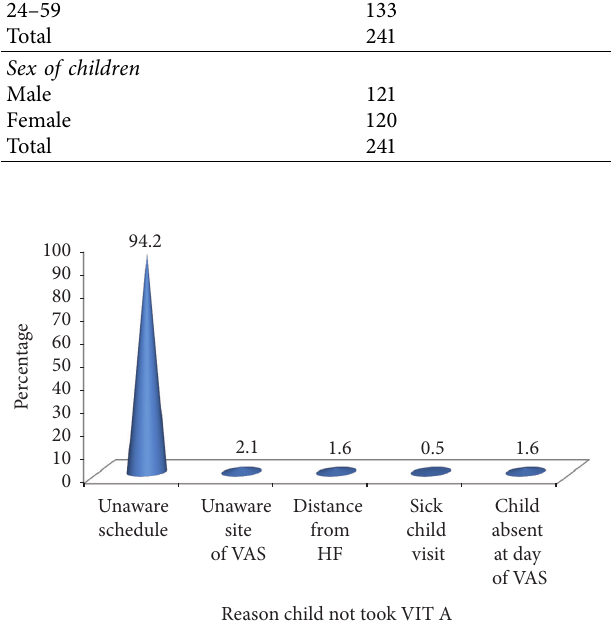
Figure 2: Reasons mentioned by mothers why the child did not take VIT A supplement in the preceding six months of the survey in Aleta Chuko woreda, SNNPR,